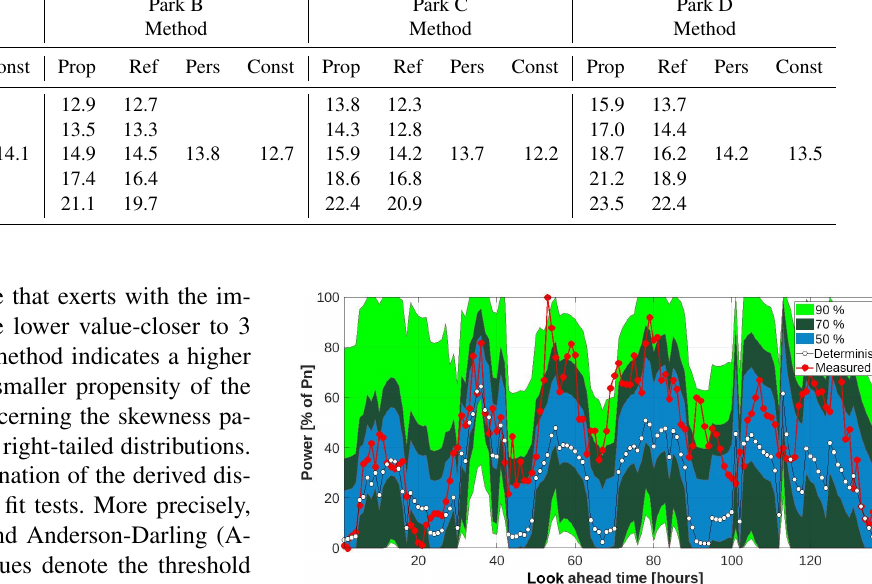
Table 2. CRPS results for the applied methods in the different parks for several confidence levels 1 − a . Park A